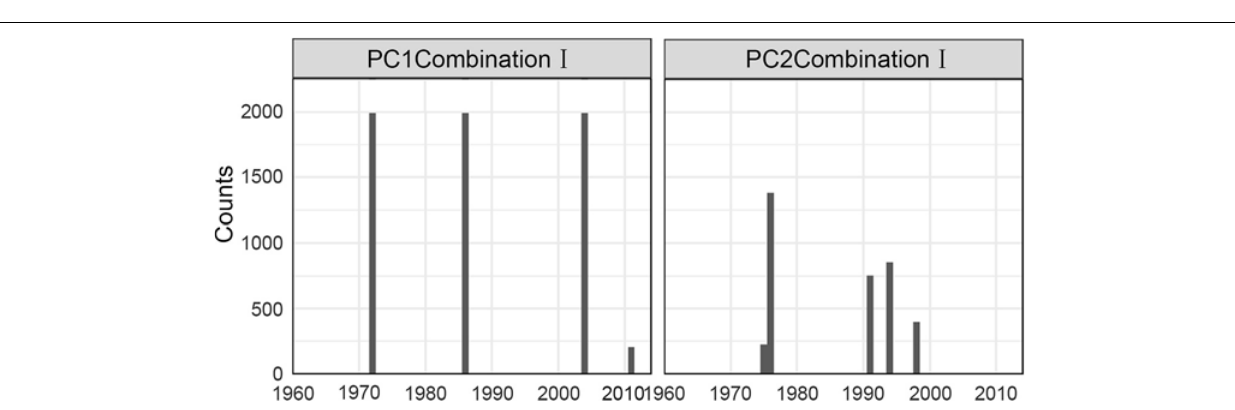
FIGURE 5 | Sensitivity results of STARTS to cut-off length for the final indicator suite (consist of ToC, LPC/ToC, MTL, MTC, T-J (cid:48) FD). Gray bars represent time nodes with considerable probability of regime